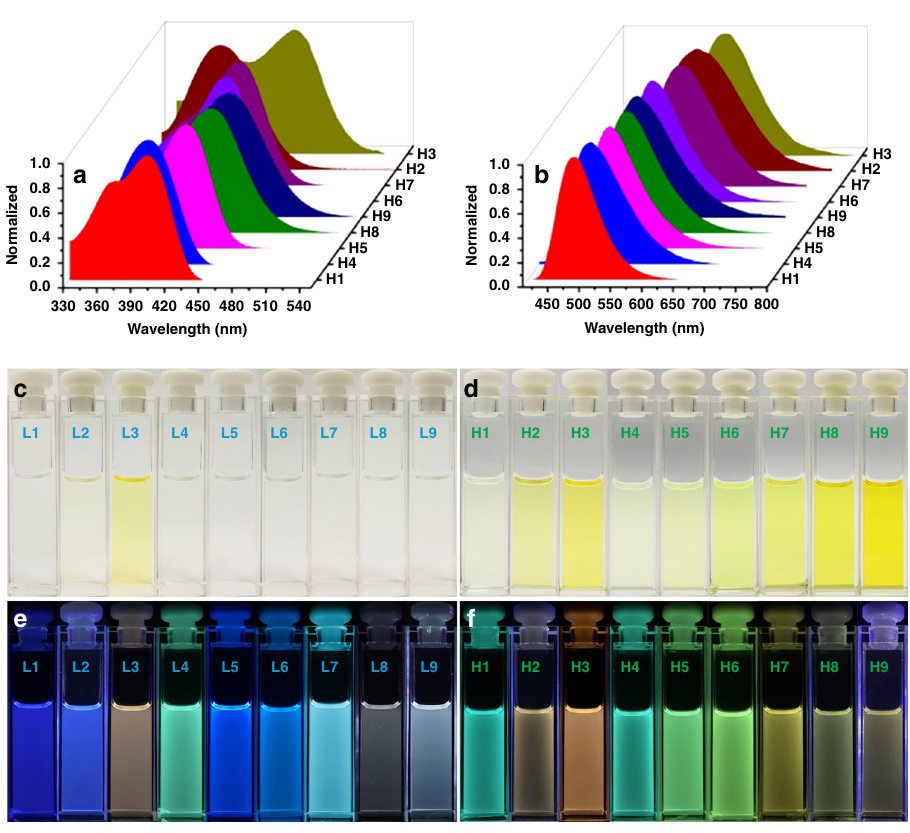
Fig. 3 Absorption, emission spectra, and photographs of L1 – L9 and H1 – H9 . Normalized absorption a and fl uorescence emission b spectra of metallacycles H1 – H9 in dichloromethane. Photographs of ligands L1 – L9 in dichloromethane in visible light c and under 365 nm light excitation e . Photographs of metallacycles H1 – H9 in dichloromethane in visible light d and under 365 nm light excitation f